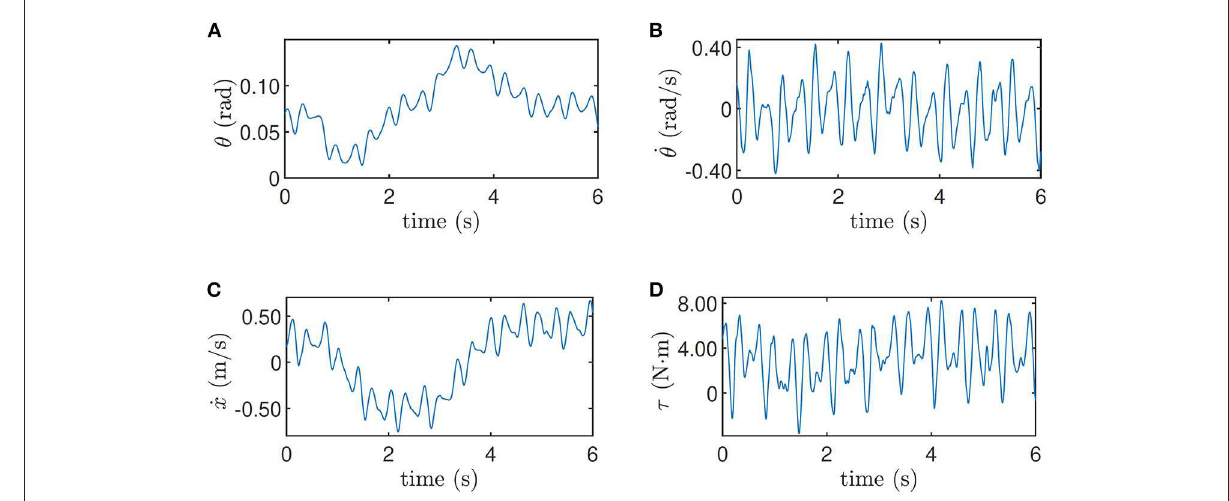
FIGURE6 Training data for height = 0.5 m on the slope. (A) Pitch angle θ , (B) pitch velocity ˙ θ , (C) line velocity ˙ x , and (D) input torque τ .